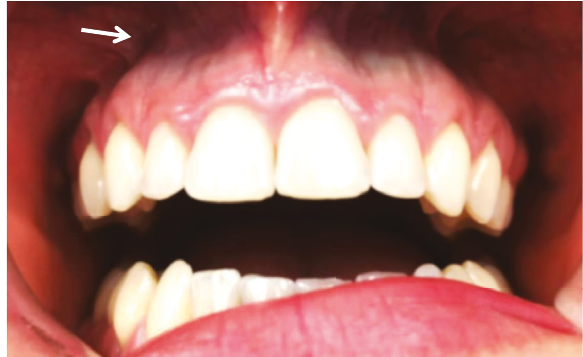
Figure 1: Dark blue pigmentation is found in the maxillary gingival